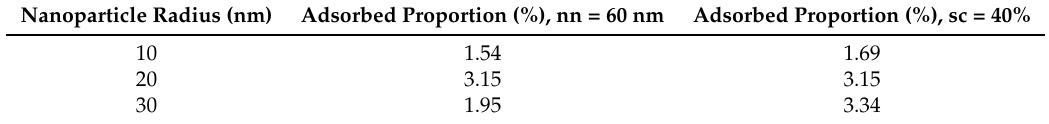
Table 6. The adsorbed proportion of the fibrinogen α C-chain in simulations with flat surfaces with attached nanoparticles with different radii for a fixed distance between centers of nearest neighbors (nn) and a fixed surface coverage of nanoparticles (sc). The surface charge density for the flat surface and the nanoparticles is − 0.001 e /Å 2 .